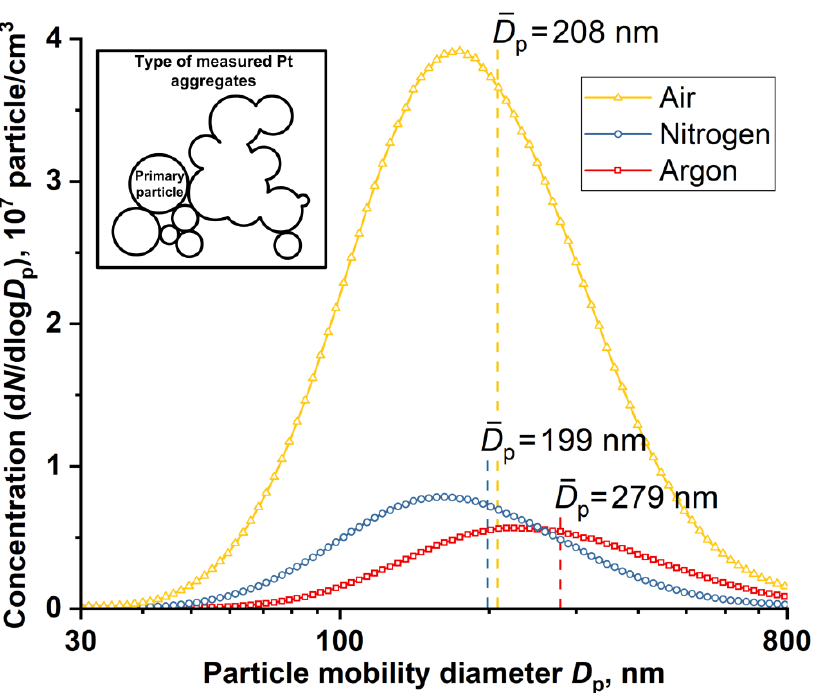
Figure 5. Particle size distributions of Pt aggregates synthesized by spark discharge under Ar, N 2 and air. The measurements were performed using an aerosol spectrometer.